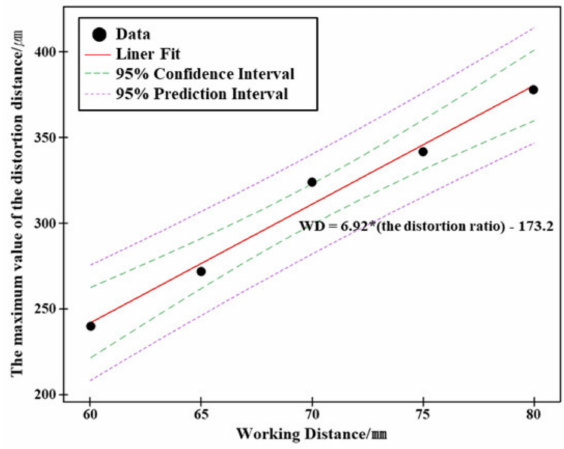
Figure 6. Regression analysis on the image angle (at five di ff erent working distances) and the distortion ratio (the maximum values of the distance between the corresponding